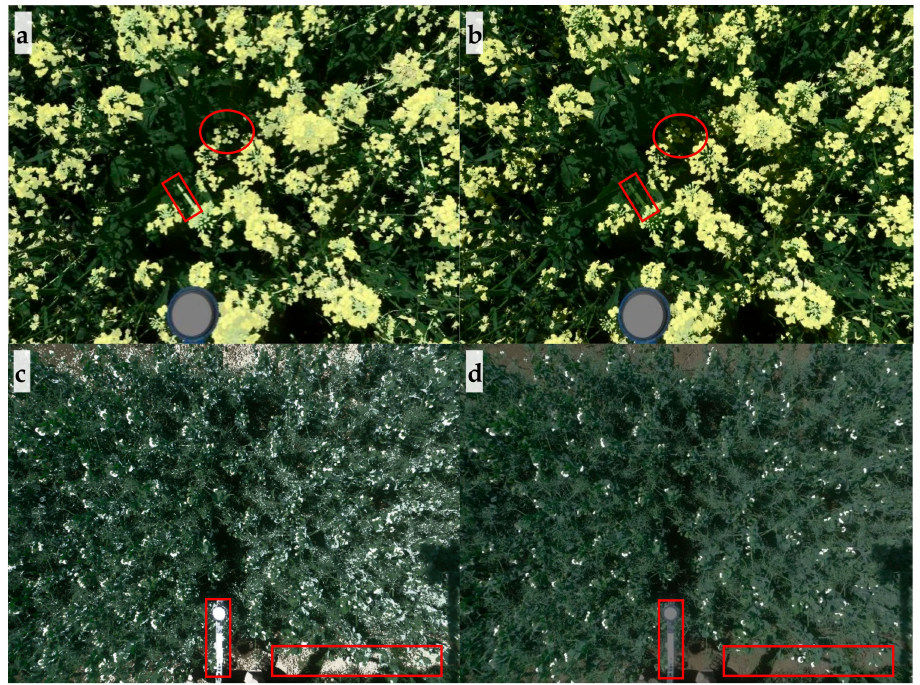
Figure 6. Detection of winter canola and pea flowers using by ( a ) and ( c ) k-means clustering and ( b ) and ( d ) thresholding. As examples, rectangles highlight the noise detected by k-means clustering while ovals highlight the flowers missed by thresholding.